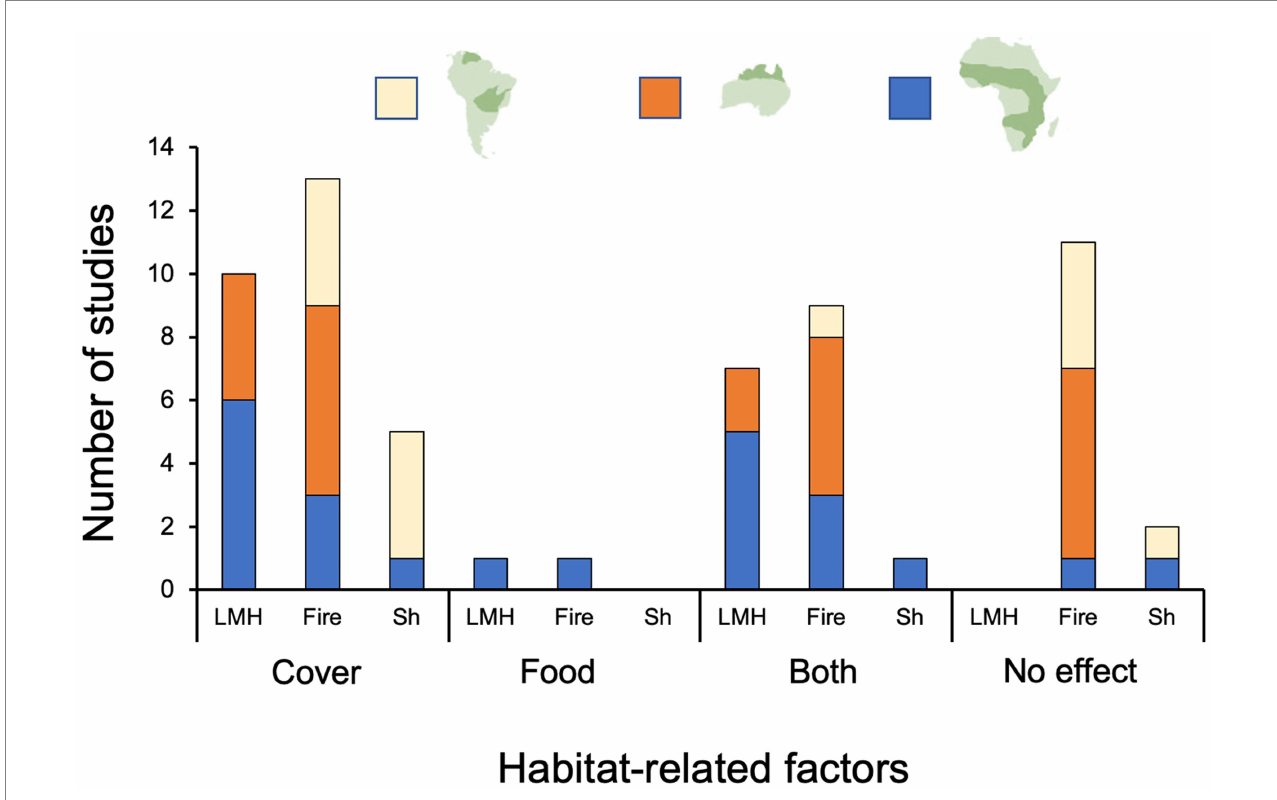
FIGURE 2 Number of published field studies from each region of tropical and subtropical savannas (beige: Neotropical; orange: northern Australian; blue: Afrotropical) in which either a conclusion was reached about which habitat-related factor—cover, food, or both—was the primary limiting factor for species or communities of non-volant small mammals or in which either no treatment effect was found or results were inconclusive (“No effect”). Studies scored “Both” included those in which some species were primarily limited by cover and others by food, as well as studies where there was evidence of both factors limiting small mammals (see Supplementary Table S1 for details). Manipulated or naturally varying factors affecting ground-level habitats and resources for small mammals were: (1) large mammalian herbivore reduction and/or removal (LMH; n = 18), (2) fire (Fi; n = 33), (3) shrub encroachment or reduction/removal (Sh; n = 8). This compilation includes substudies within individual papers for a total sample of 63. Additionally, two studies in Africa and one in South America assessed drought or rainfall seasonality effects (not included in the figure). The African studies indicated the role of “Cover” and “Both” while the South American study was inconclusive. Soil type (ST) and soil enrichment (SE)—which both concluded enhanced cover increased overall small- mammal abundance—were not included in the graph either, as only one study examined each of these treatment types (see “Summaries of Findings and Research Gaps by Region” and Supplementary Table